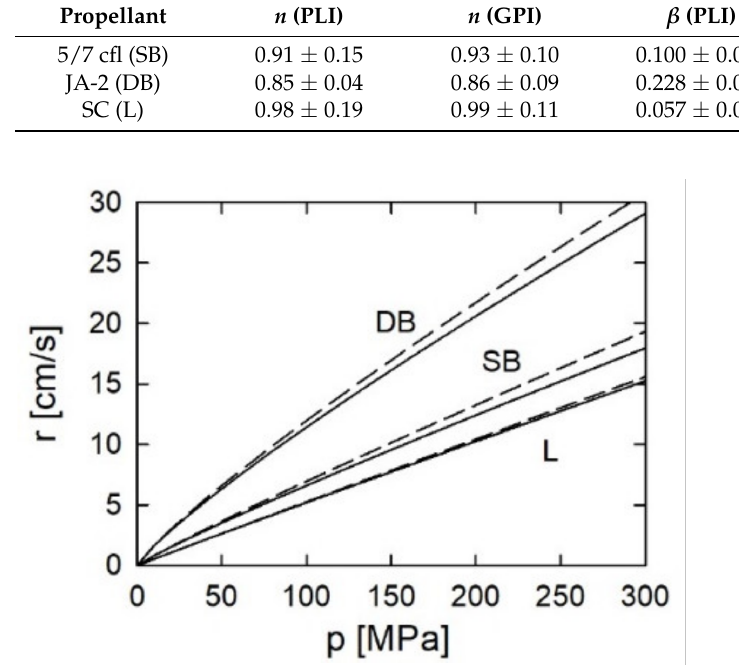
Figure 4. Plots of dependence of burning rate on pressure: solid lines plasma jet ignition, dashed lines–gunpowder